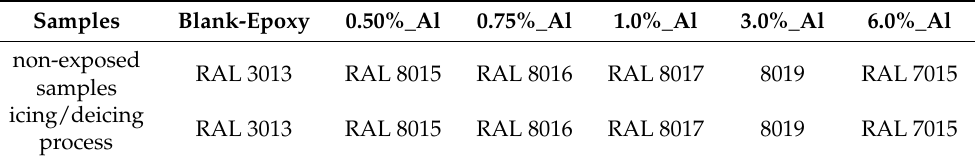
Table 3. Discoloration testing results for the epoxy matrix without and with adding Al NPs before and after the icing/deicing process.